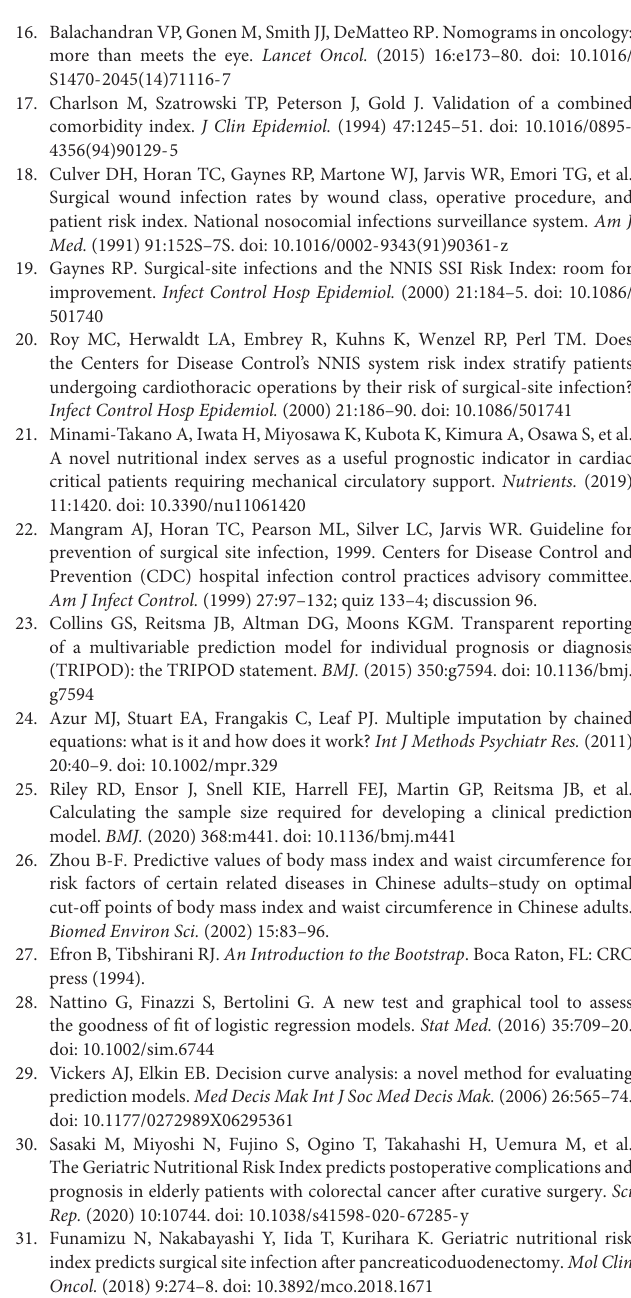
association between preoperative LOS and the risk of SSI. (B) The association between operative time and the risk of SSI. (C) The association between estimated blood loss and the risk of SSI. All variables (preoperative LOS, operative time, estimated blood loss) in Table 1 were adjusted except self. Supplementary Figure 2 | Screenshot of the online program used for the prediction of SSI risk. Supplementary Figure 3 | Diagnostic plots of accuracy and suitability of existing predictors. (A) The Cook’s distance, the studentized residuals, and the hat value of the model. (B) The variance inflation factor of the